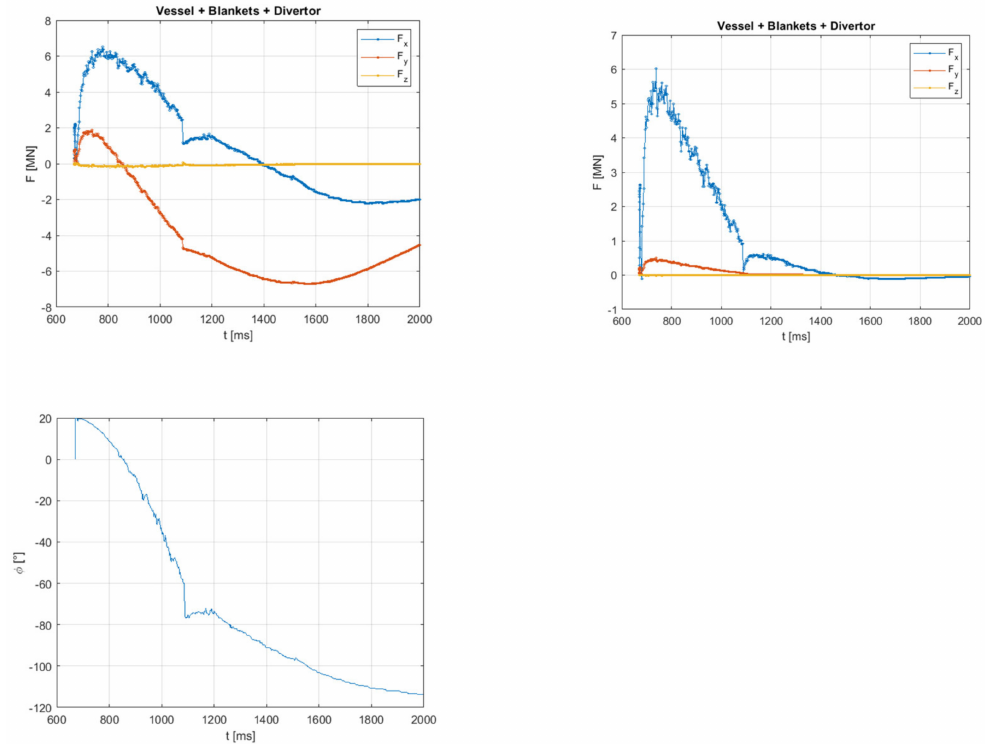
Figure 9. Obtained with Model #2. Cartesian components of net lateral forces ( F x , F y , F z ) created in the 360-degree Vacuum Vessel with the blanket and divertor by interaction of the anti-symmetric halo currents with external magnetic fields: toroidal (first plot) and poloidal (second plot); and rotation of resultant vector of lateral EM